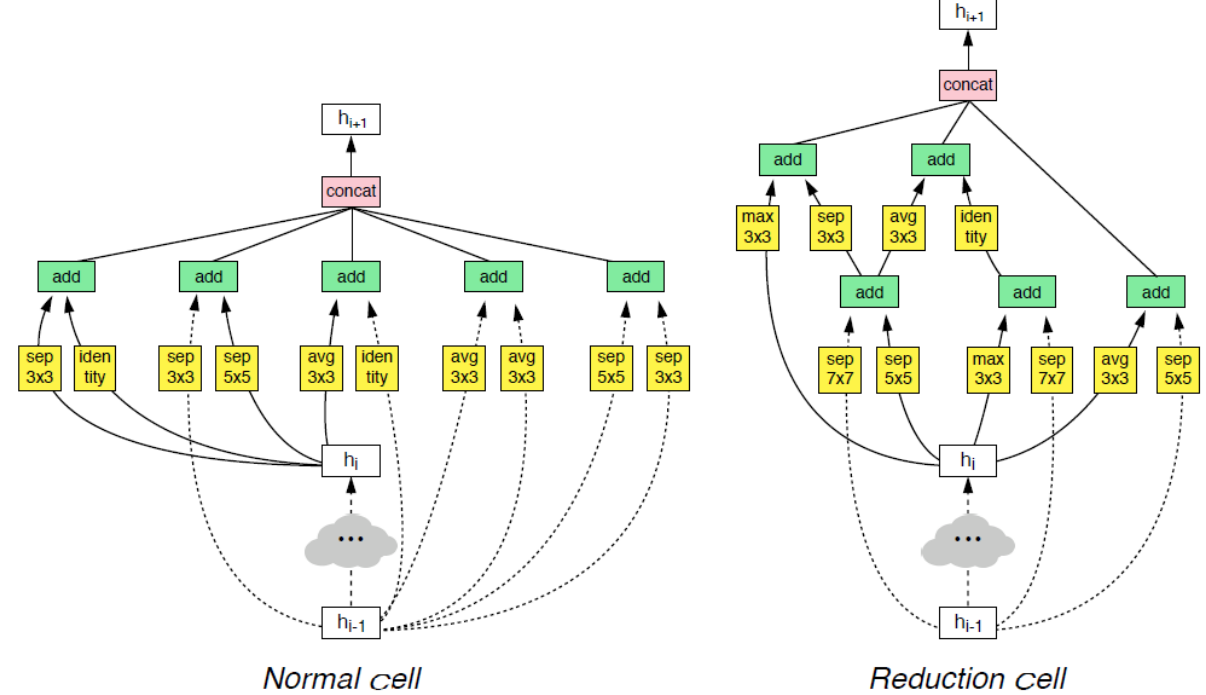
Figure 2. Architecture of the NASNet’s convolutional cells with B=5 blocks. The input (white) is the hidden state from previous activations (or input image). The output (pink) is the result of a concatenation operation across all resulting branches. Each convolutional cell is the result of B blocks. A single block corresponds to 2 primitive operations (yellow) and a combination operation (green)